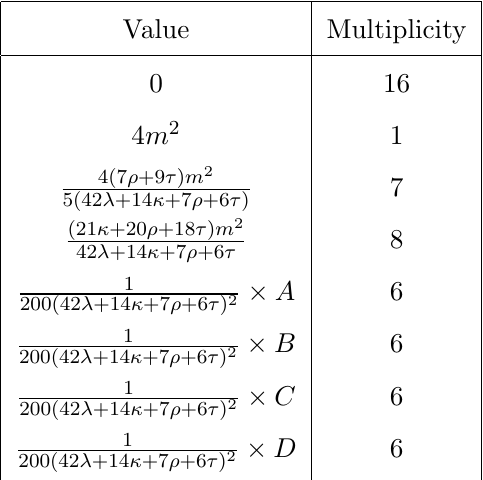
Table 13 . Scalar mass eigenstates for the SSB pattern SU(3) ! PSL(2 ; 7) using a 28 of SU(3). the perturbative range, we can rescale all the quartics by a factor s and (cid:16) by a factor This leaves the eigenvalues unchanged and puts us into the perturbative